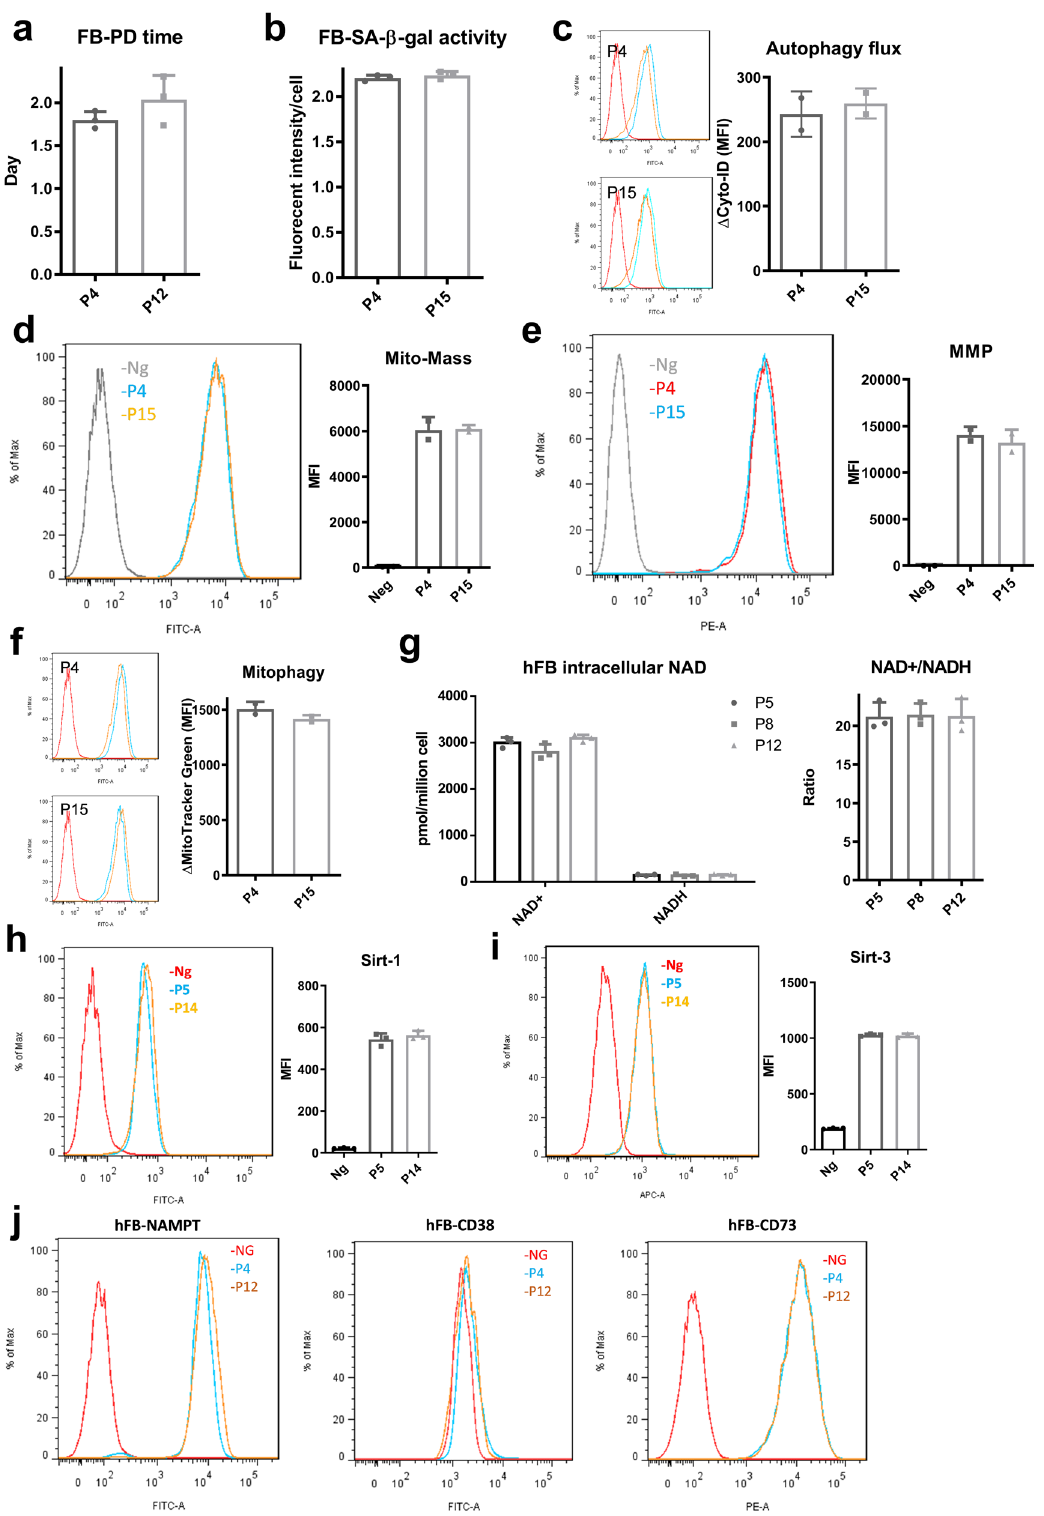
Fig. 7 Human dermal fi broblasts (hFBs) under replicative expansion exhibit limited cellular senescence, mitochondrial dysfunction, and NAD + decline. a Population doubling time of hFBs at early and late passage. b SA- β -gal activity for culture-expanded hFBs. c No signi fi cant difference for autophagic fl ux in P4 and P15 hFBs. Red line: negative control. Orange line and blue line represents basal autophagy and with autophagy inhibitor Ba fl iomycin-A (Baf-A), respectively. d Mitochondrial mass and e mitochondrial transmembrane potential (MMP) showed no difference for P4 and P15 hFBs. f Mitophagy also showed no signi fi cant difference in hFBs during culture expansion. Red line: negative control. Orange line and blue line represents untreated and with mitochondrial uncoupler (FCCP) treatment, respectively. g Intracellular NAD + and NADH levels, as well as NAD + /NADH ratios are relatively stable during culture expansion of hFBs. h Sirt-1 and i Sirt-3 protein expression determined by fl ow cytometry. j The expressions of NAD + metabolic enzymes NAMPT, CD38, and CD73 were all comparable for hFBs at different passages as determined by fl ow cytometry. Biological replicates ( n ): n =